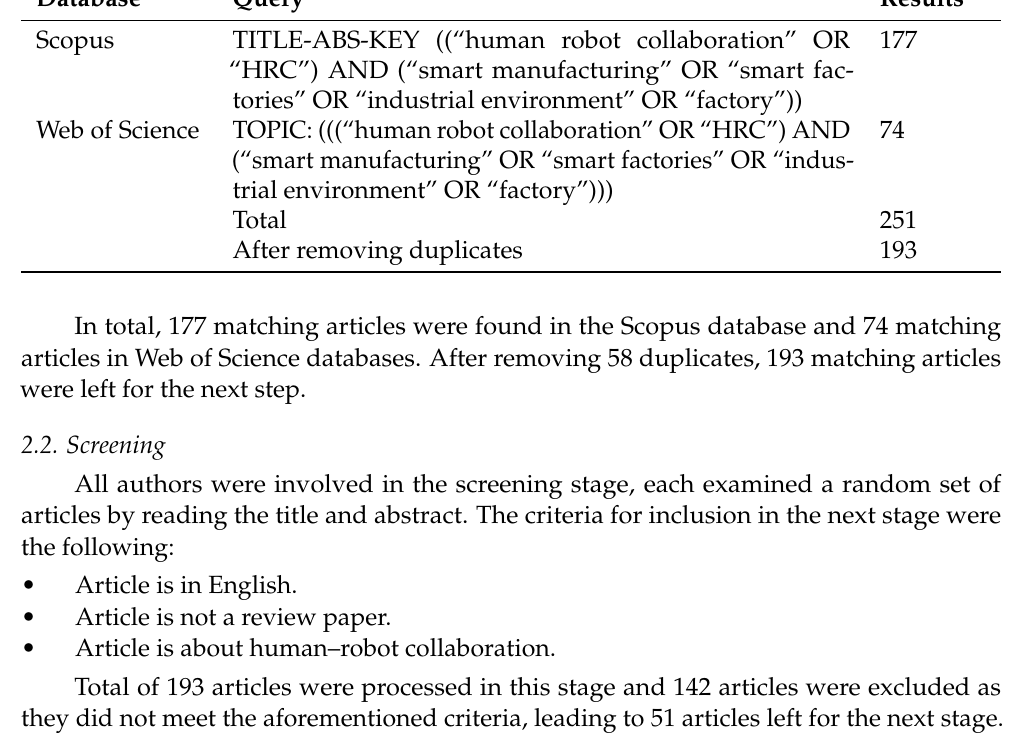
Table 1. Queries used in search and matching article count in each database.